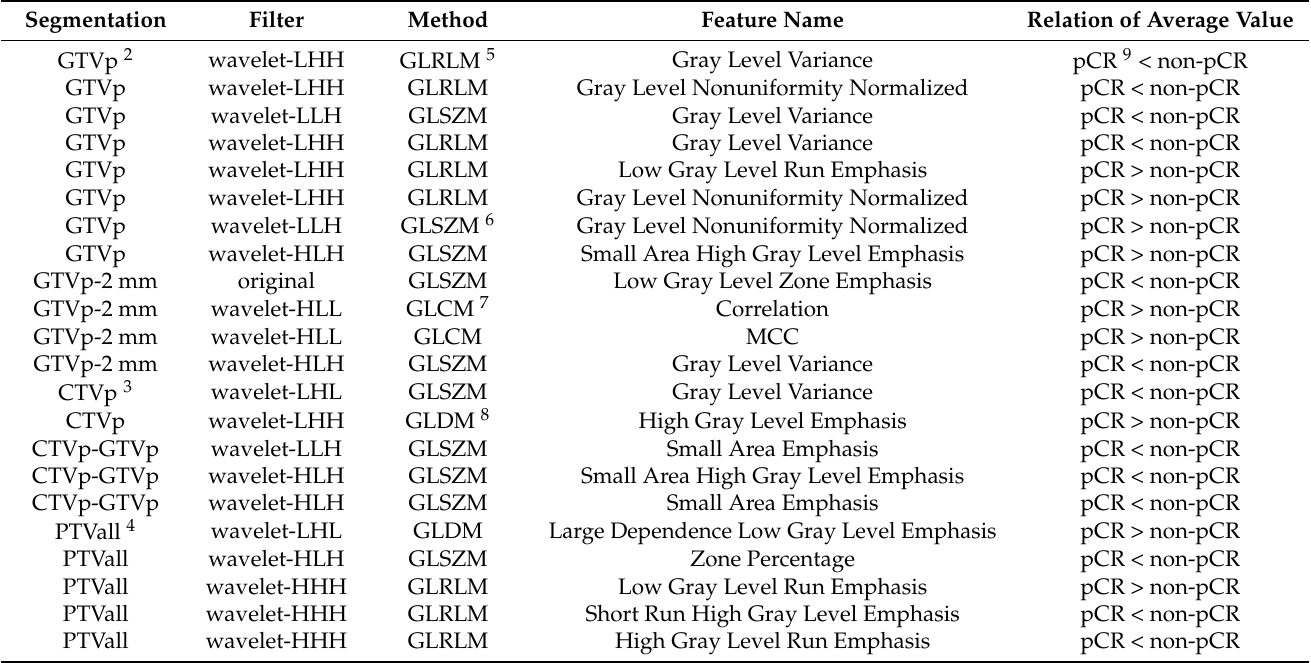
Table 3. Selected features by LASSO 1 regression analysis.